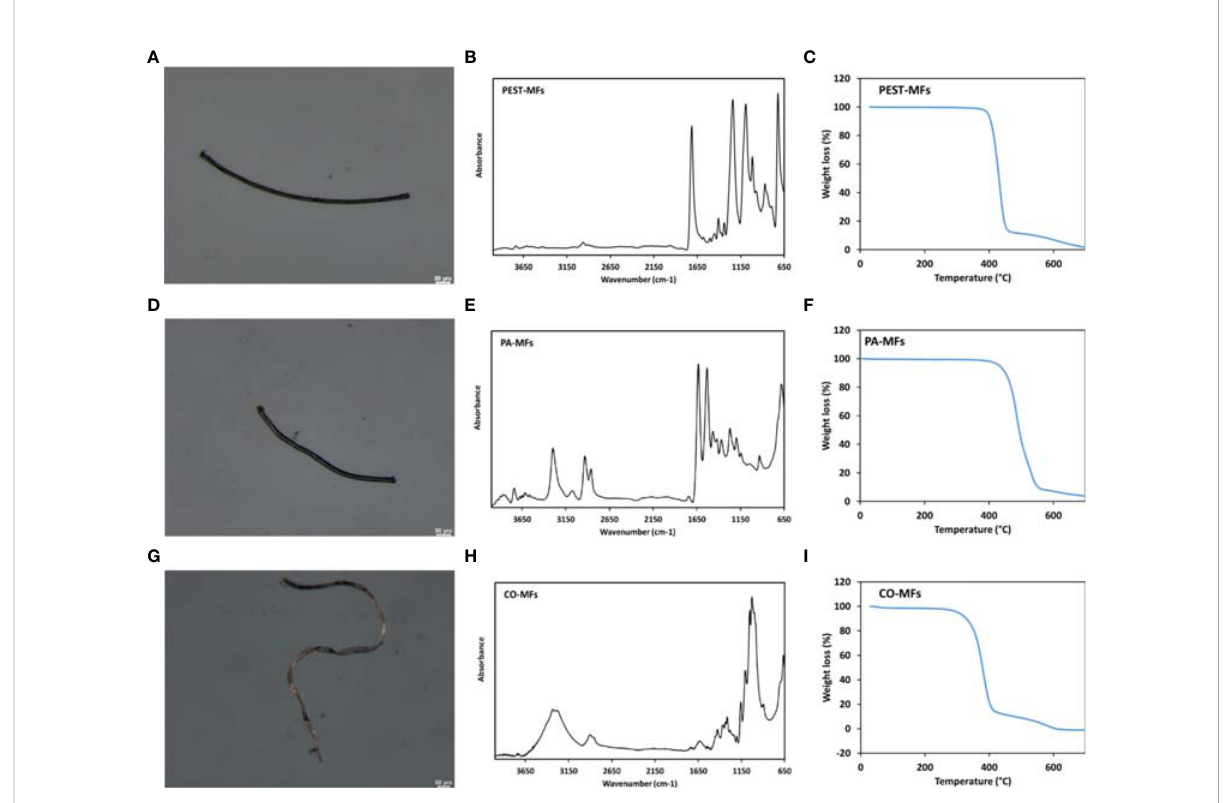
FIGURE 1 Optical micrographs, FTIR spectra and TGA traces of PEST-MFs (A – C) , PA-MFs (D – F) and CO-MFs (G – I) produced for the